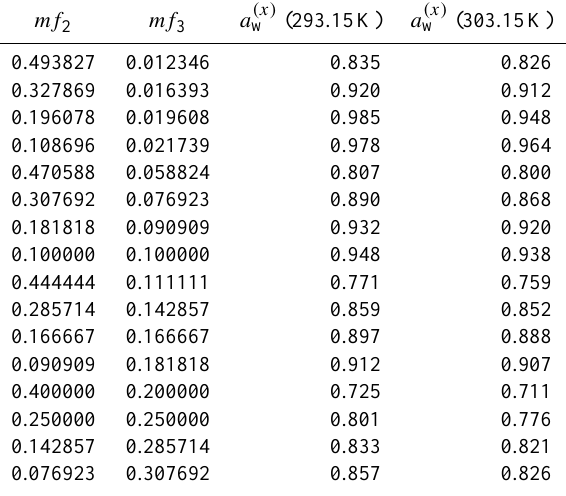
Table A6. Bulk water activity measurements of the system water